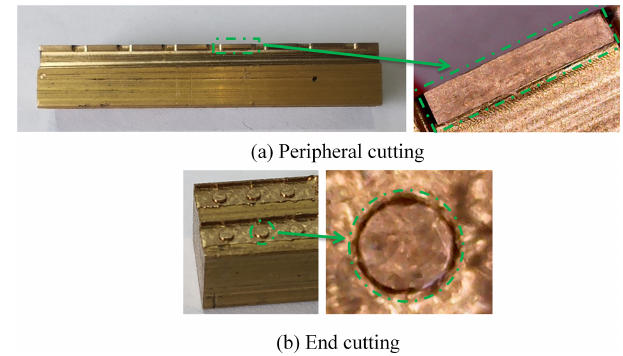
Figure 9. Workpiece preparation for cutting.